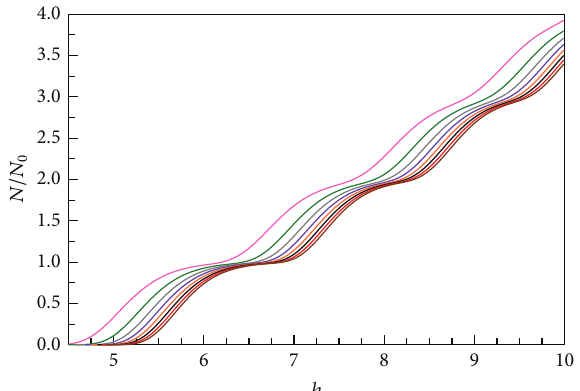
Figure 4: The exit neutron count 𝑁 𝑒 /𝑁 0 as a function of the slit width ℎ for several values of Φ 2 close to 5×10 3 ( 𝑁 0 is the number of neutrons entering the slit in each quantum state). Eight curves from left to right correspond to Φ 2 × 10 −3 = 1;2;3;4;5;6;7;8 ; neutron count decreases with increasing Φ 2 .